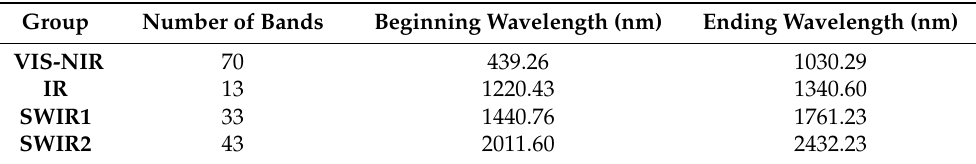
Figure 2. Mean, brightness-normalized spectra for 15,537 training points in the Live , Brown , and Leafless classes ( A ). The Live ( B ), Brown ( C ), and Leafless ( D ) mean spectra are also shown with their associated band standard deviation windows in grey. These distinct spectra show the degree of separation between the different classes. Table 1. CAO VSWIR wavelengths used in the classification